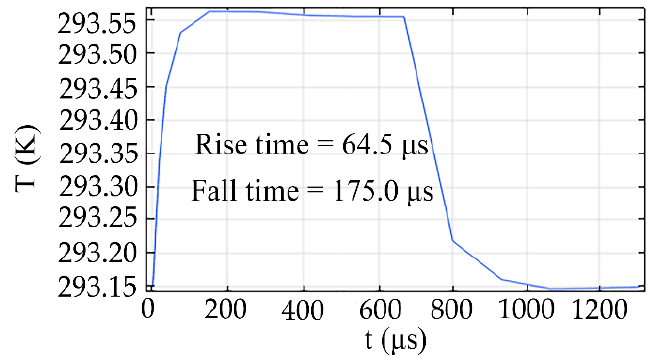
Figure 9. The response time curves of the graphene TO switch with a d of 4 μ m and a of 2 μ m.